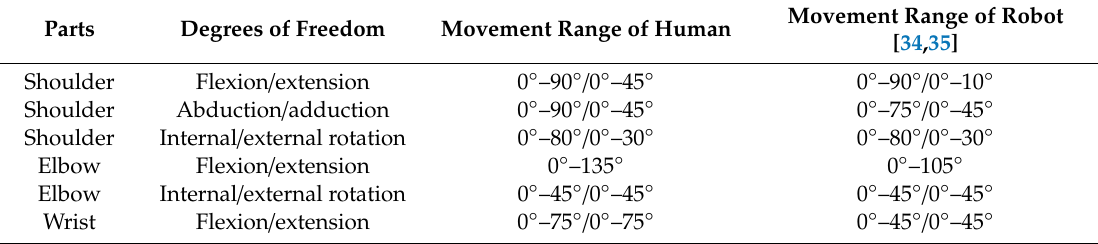
Table 1. Free distribution of human upper limbs and robot degrees of freedom.